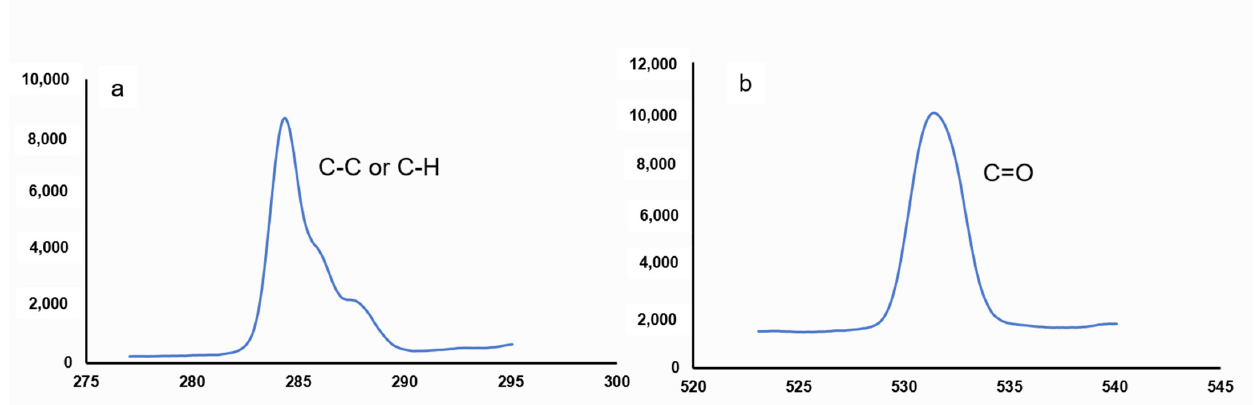
Figure 4. XRD pattern of Catalpa bignonioides fiber.